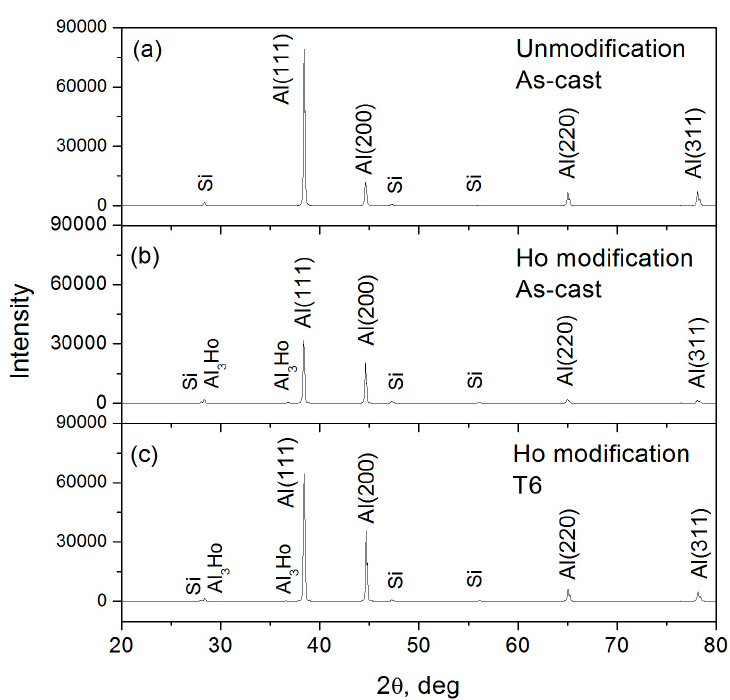
Figure 4. XRD patterns of the A356 alloys, ( a ) Ho-free, as-cast; ( b ) 0.2 wt.% of Ho addition, as-cast; ( c ) 0.2 wt.% of Ho addition, T6.